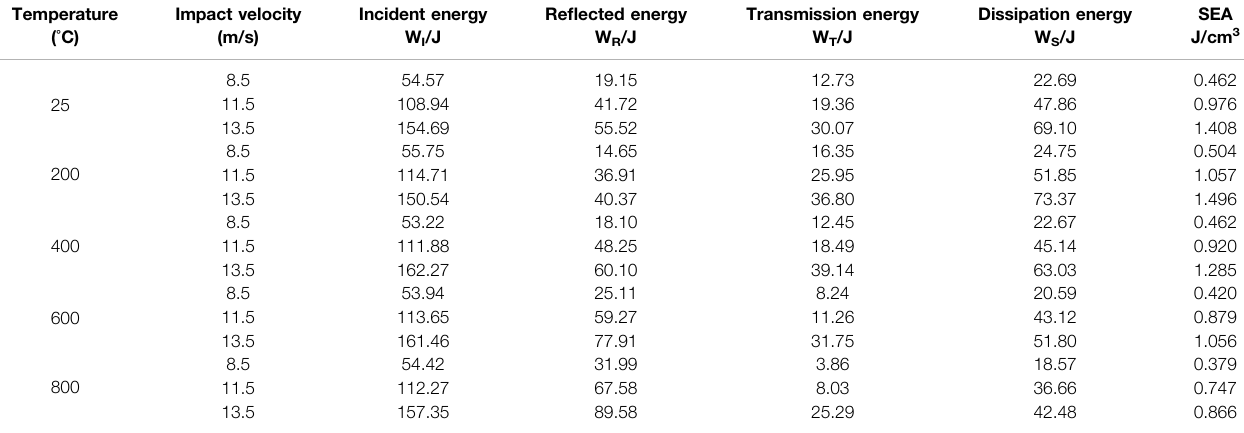
TABLE 1 | Energy dissipation of granite under different working